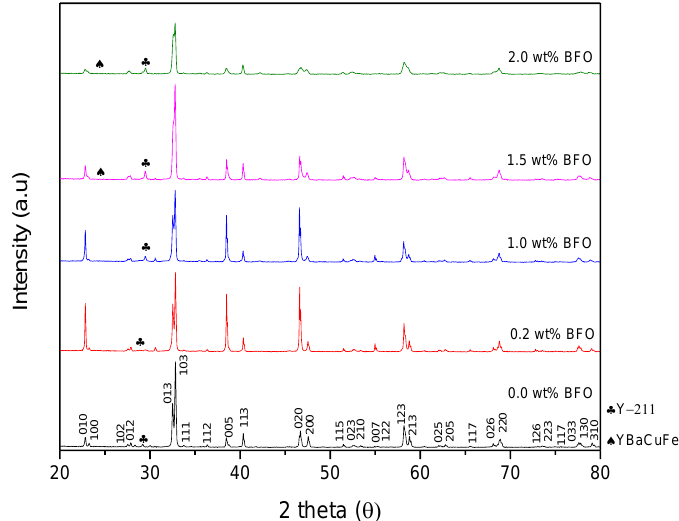
Figure 2. X-ray diffraction pattern of the Y-123 + x wt.% of BFO.